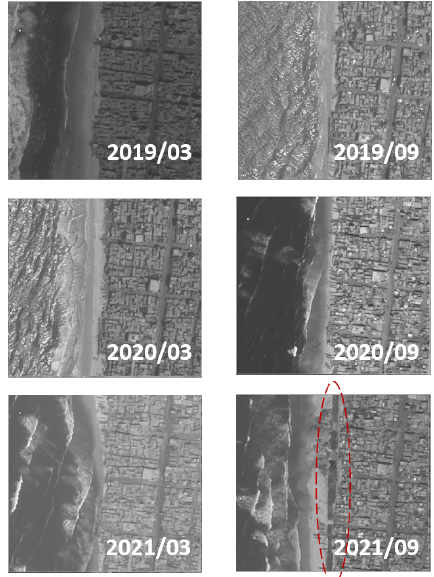
Figure 6. Ortho-rectified panchromatic images from Pleiades constellation to keep track of the construction of the protection structure (in